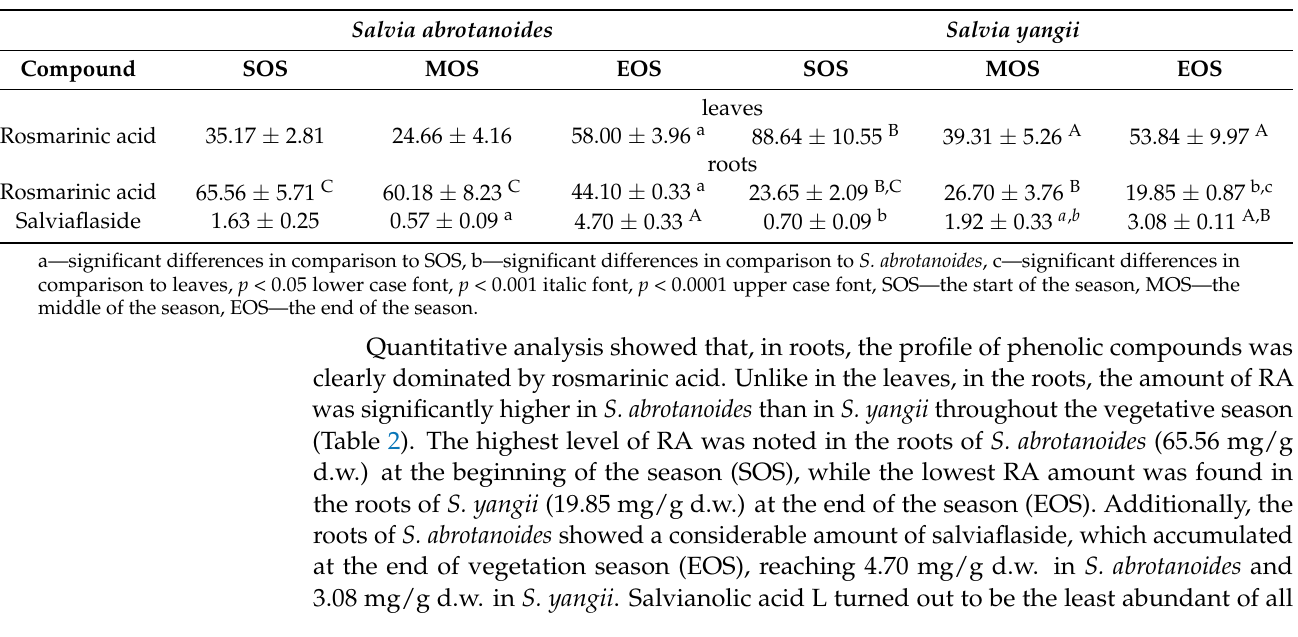
Table 2. The content of rosmarinic acid and salviaflaside [mg/g d.w. ± SD, n = 3] in leaves and roots of S. abrotanoides and S. yangii , at the start of the vegetation season (SOS), middle of the season (MOS) and end of the season (EOS). Statistical significance of differences in chemical parameters between samples was evaluated with a one-way ANOVA with post hoc Tukey’s multiple comparison